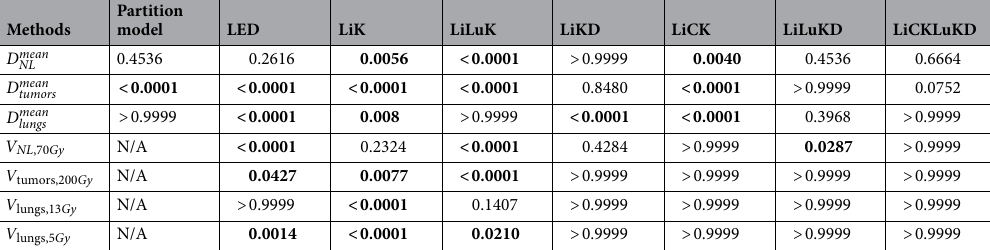
Table 3. Statistical analysis results of different VSV and LED dosimetric results as compared to MC. Significant values are in bold.